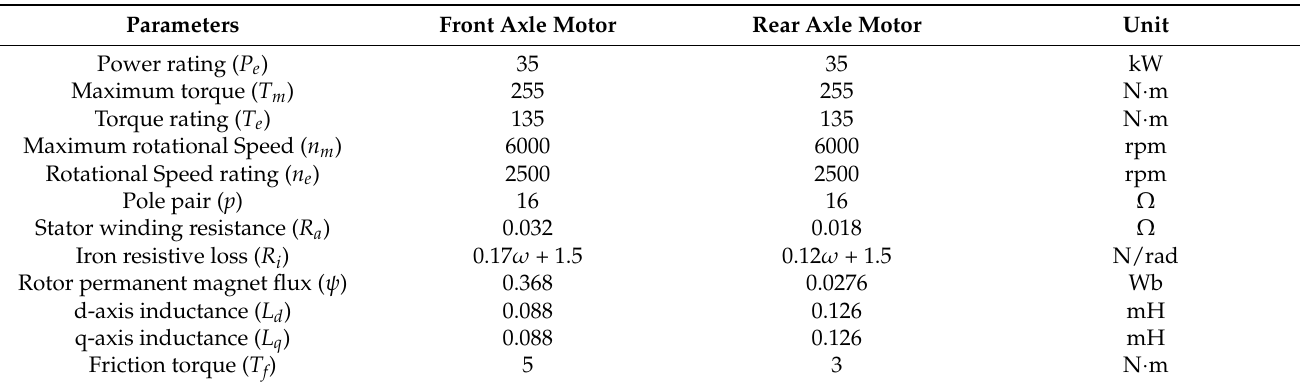
Table 2. Motor parameters of the front and rear axles.